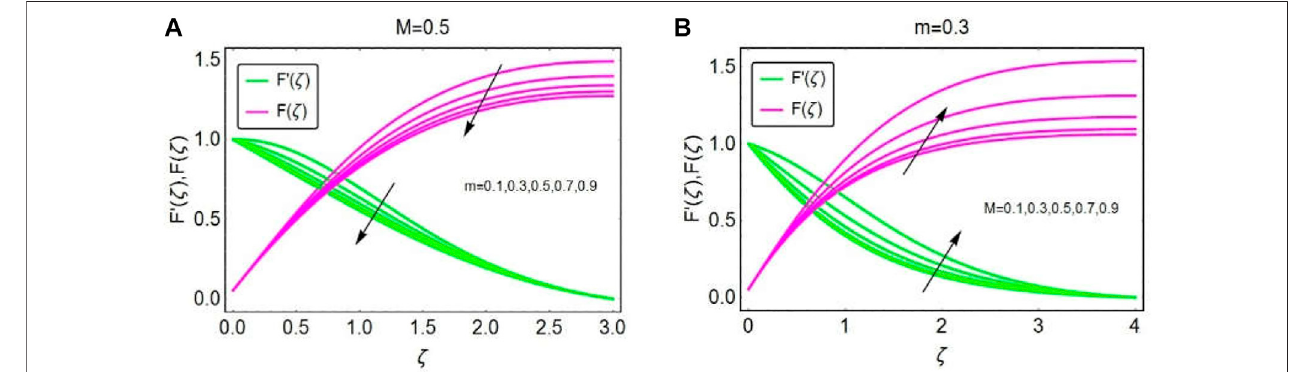
FIGURE 2 | In fl uence of (A) m and (B) M on the velocity fi eld.